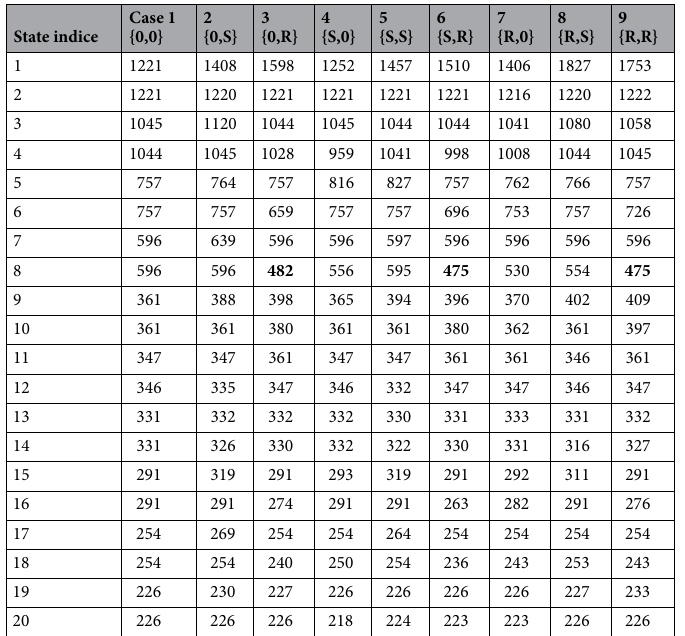
Table 1. Calculated absorption wavelengths for the “7-residue chain” with zero, one or two Gly OH residues at one end only, coded by its absence (0) or location on {N-terminal, C-terminal} and chirality (S or R) via {(0,S,R),(0,S,R)}. For example, {0,R} refers to a C-terminal R Gly OH only, with unmodified glycine at the N-terminal. Wavelengths (nm) and transition strengths are from the RPA calculations. Significant values are given in